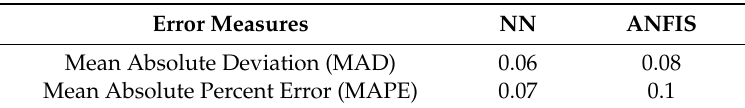
Figure 5. The comparisons of actual and forecasted attendance rates. Table 5. Error measures of the forecasting results.